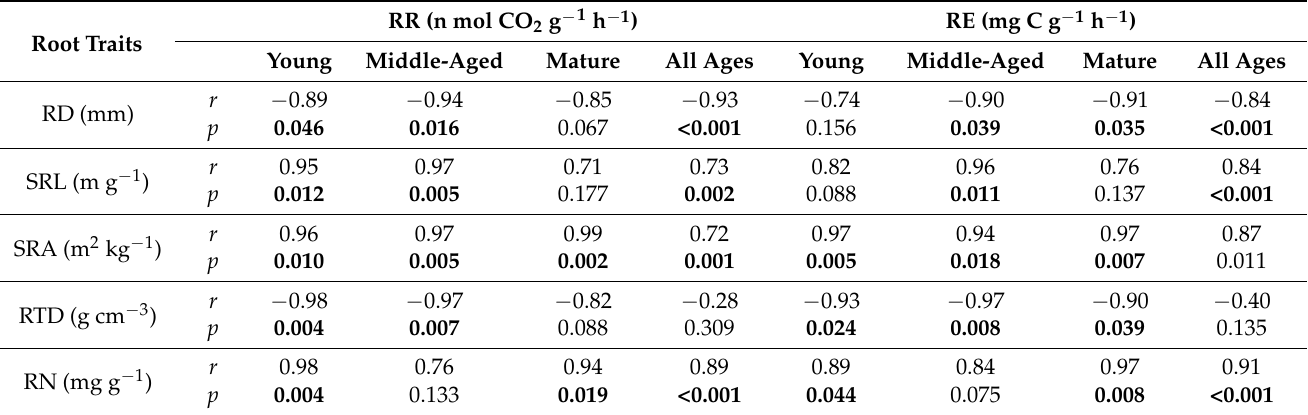
Table 2. Relationships of root respiration and exudation rates to root morphological traits and root nitrogen concentration in Fraxinus mandshurica at different tree ages. Root Traits